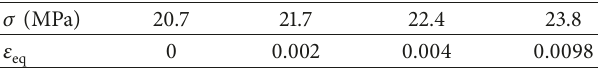
Table 1: The matrix mechanical parameters.